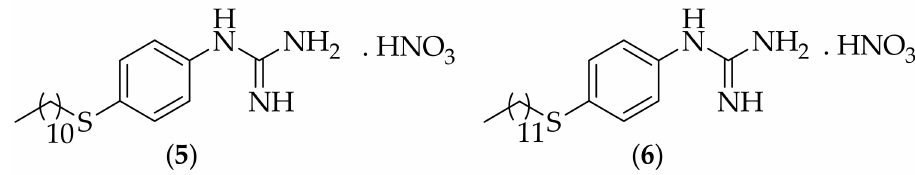
Figure 3. Phenyl guanidinium salt antifungal agents ( 5 ) and ( 6